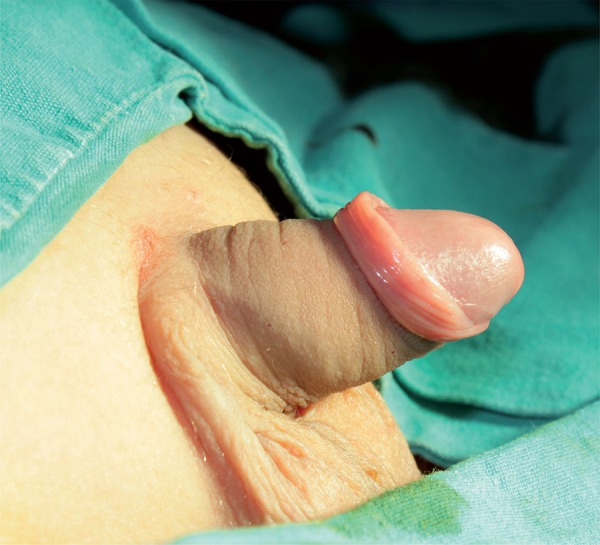
Perioperative image obtained after cyanoacrylate application.